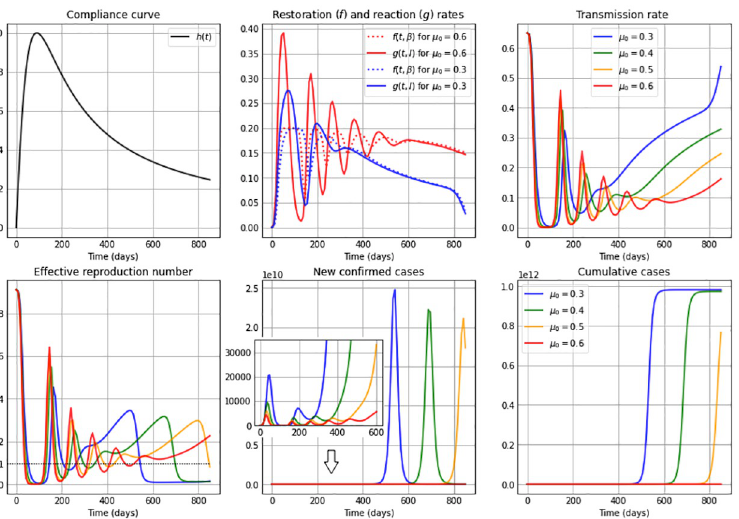
Fig 6. Simulations for a low restoration coefficient ν = 0.2. The first subplot depicts the shape of the compliance curve h ( t ) = ( a + 2 b ) t /( t 2 + at + b 2 ), with b = 90, a = 40, and the second plot in the first row illustrates the restoration rate f ( t , β ) (dotted) and the reaction rate g ( t , I ) (solid). The remaining subplots show: The transmission rate β ( t ), the effective reproduction number R ð t Þ , the new confirmed cases eE ( t ), and the cumulative cases E ( t ) + I ( t ) + R ( t ). The e maximum value μ 0 of the reaction coefficient ( μ ( t ) = μ 0 h ( t )) used in each subplot is: μ 0 : 0.3 (blue); 0.4 (green); 0.5 (orange) and 0.6 (red), and the remaining parameter values and initial conditions are as in Table 2.